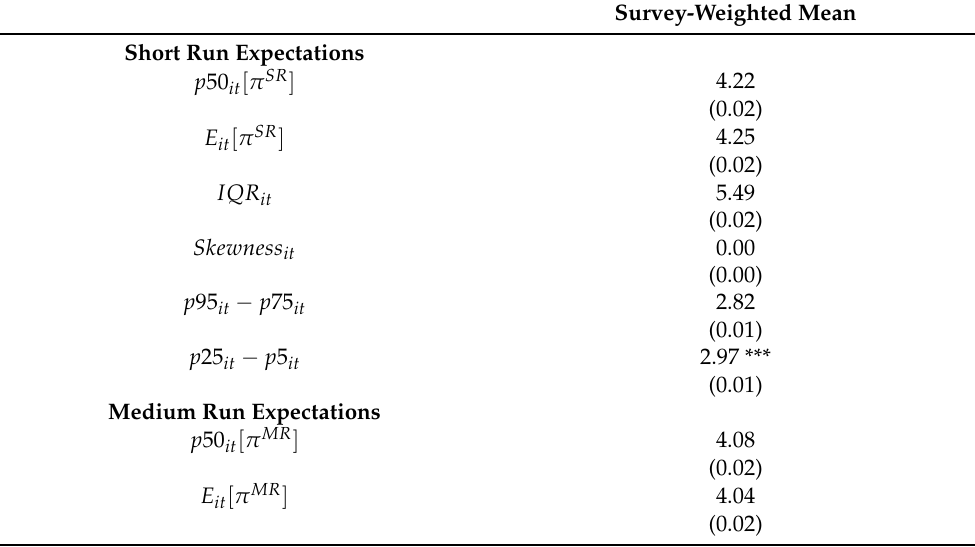
Standard errors in parentheses. *** p <